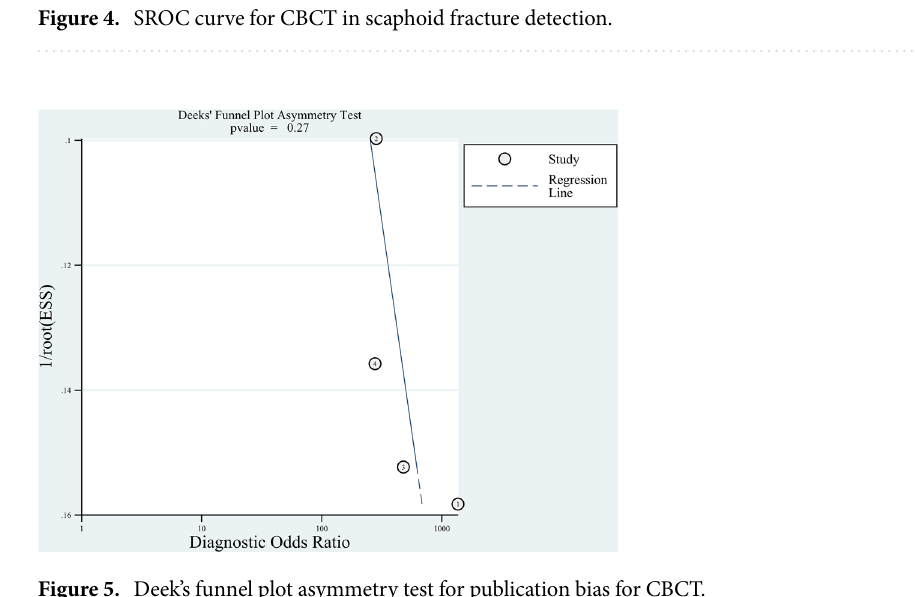
Figure 5. Deek’s funnel plot asymmetry test for publication bias for